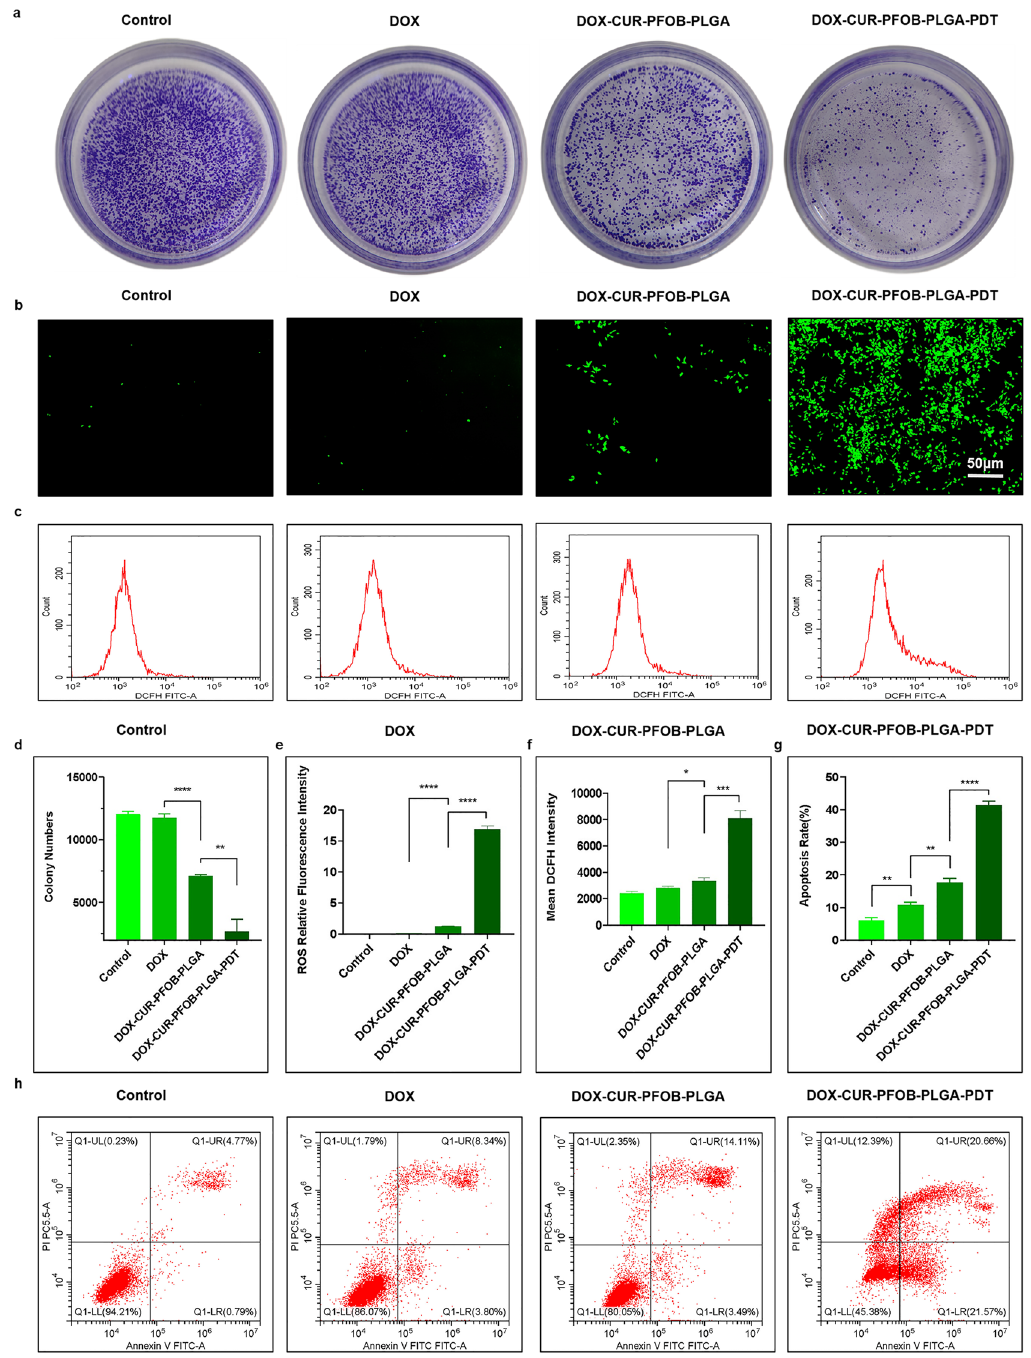
Figure 6. Proliferation 、 ROS generation capacity and apoptosis of MCF-7 cells on DOX–CUR–PFOB–PLGA NPs combined with PDT. ( a ) Digital camera photos of the survival and proliferation behavior of MCF-7 cells cultured with DOX, DOX–CUR–PFOB–PLGA or DOX–CUR–PFOB–PLGA and PDT for 14 days (The cells were stained with crystal violet); ( b ) Images of the generation of ROS by the inverted fluorescence microscope; ( c ) FCM detection of intracellular DCFH fluorescence intensity; ( d ) Statistics of colony numbers of MCF-7 cells; ( e ) Statistics of ROS relative fluorescence intensity; ( f ) Statistics of DCFH fluorescence intensity; ( g ) Statistics of the total apoptosis rate in early and late stages. ( h ) Apoptosis incidence quantified by flow cytometry through Annexin V and PI staining (Upper left quadrant (UL): cellular debris, lower left quadrant (LL): live cells, upper right quadrant (UR): late apoptotic cells, lower right quadrant (LR): early apoptotic cells.). Data are expressed as mean ± standard deviation (SD) and analyzed by the GraphPad Prism 8.0 (https:// www. graph pad. com/ updat es) and Image J 1.46 r (https:// imagej. nih. gov/ ij/ docs/ guide/ 146. html) software, * P < 0.05; ** P < 0.01; *** P < 0.001; **** P <